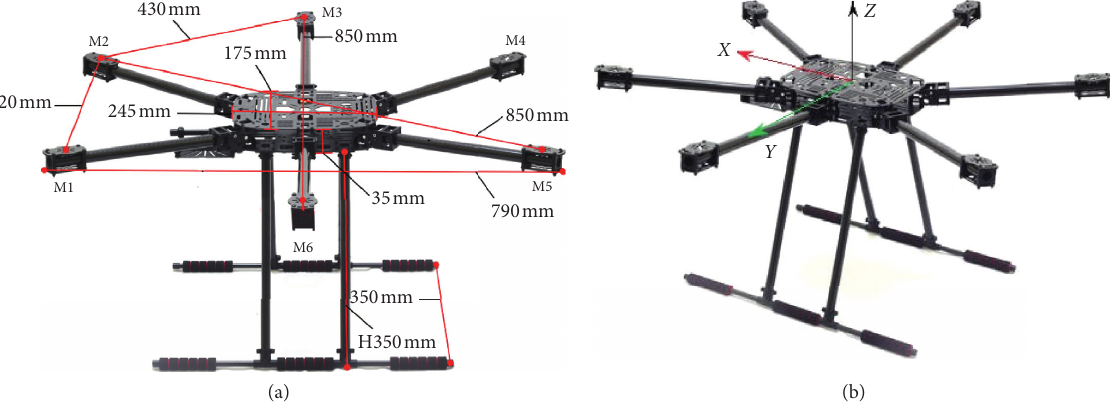
Figure 1: Information of the “ X ” hexarotor UAV: (a) simplified structure of the “ X ” hexarotor UAV and (b) coordinate system of the “ X ” hexarotor